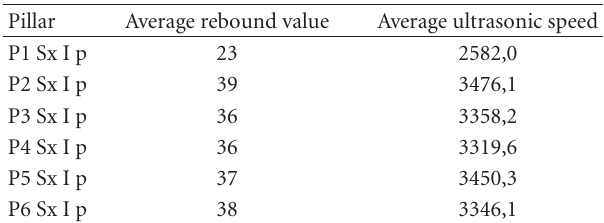
Table 5: Left side pillar (Sx): First floor.